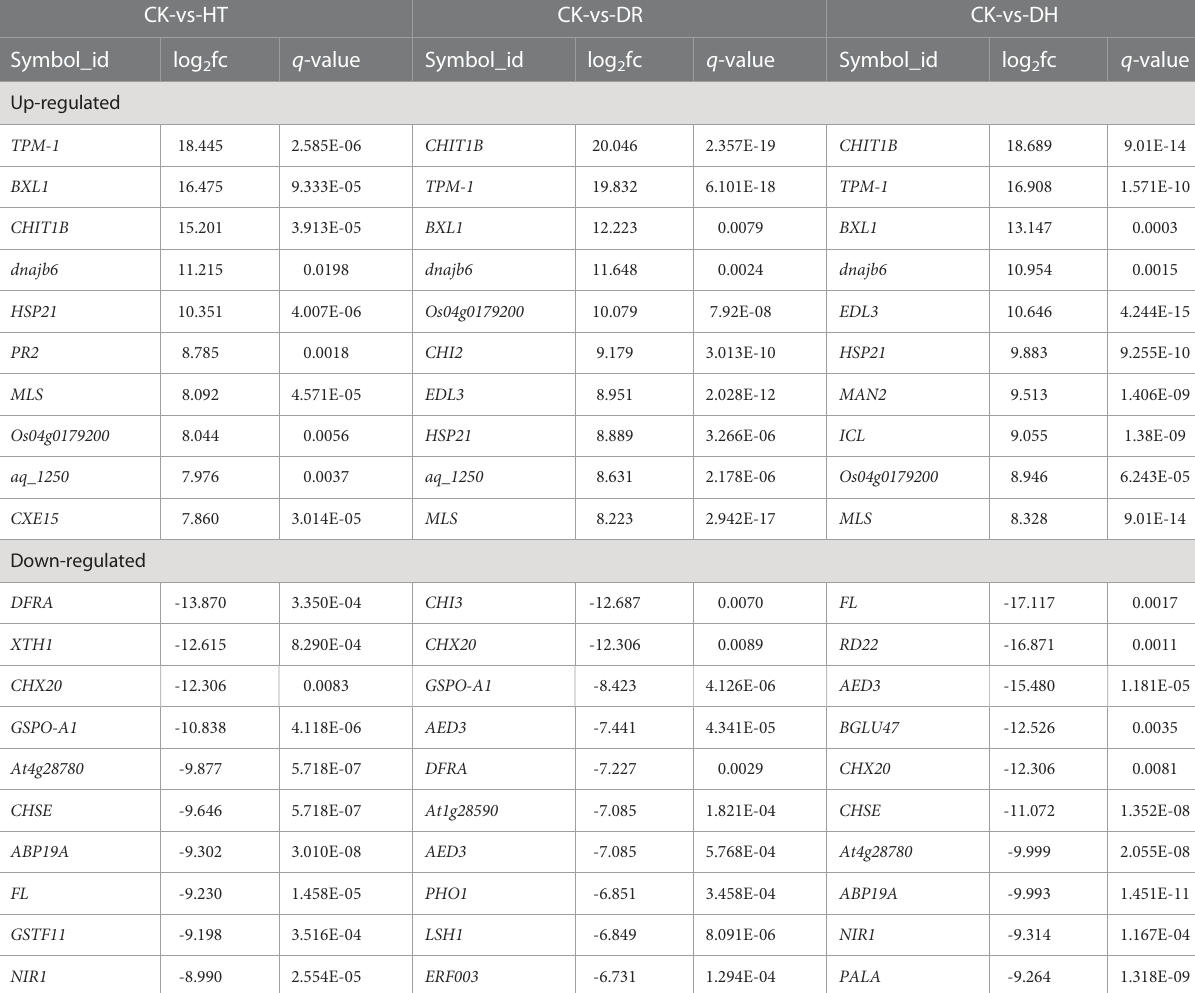
TABLE 1 Top 10 common up- and down-regulated DEGs among the overlapping genes in HT, DR, and